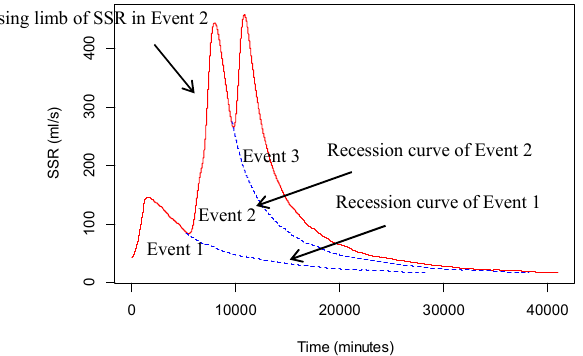
Figure 4. A schematic diagram of the separation of subsurface runoff (SSR) for different events.